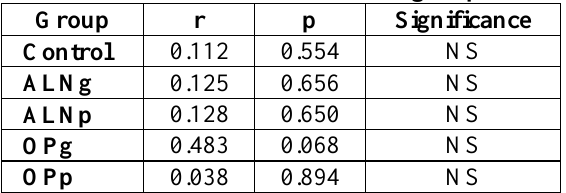
Table 9: Spearman’s Correlation Coefficient (r) between salivary concentration of OPG and TNFα in control and subgroups Group r p Significance